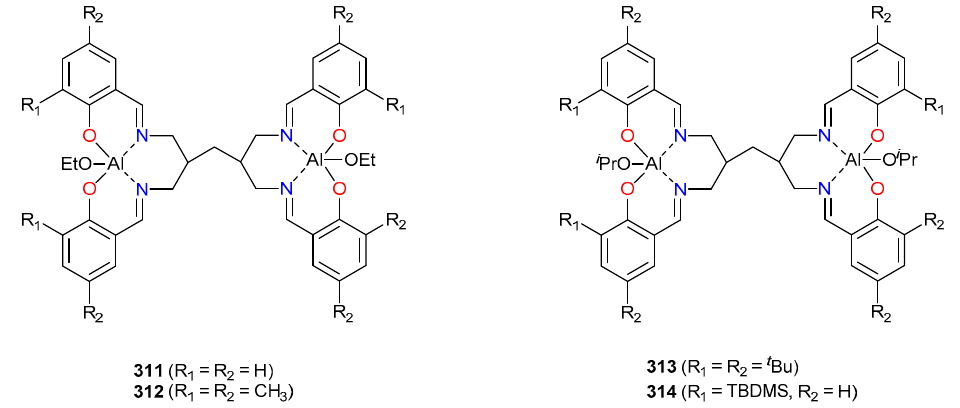
Figure 46. Bimetallic Al-salen complexes 311–314 [131].